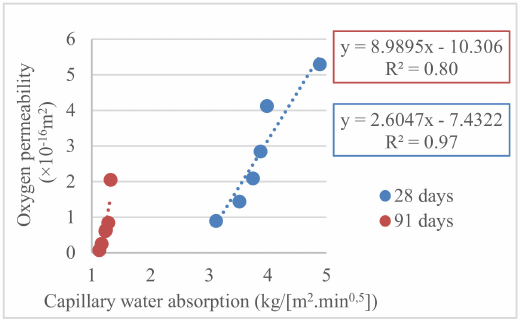
Figure 10. Relationship between oxygen permeability and capillary water absorption results at 28 and 91